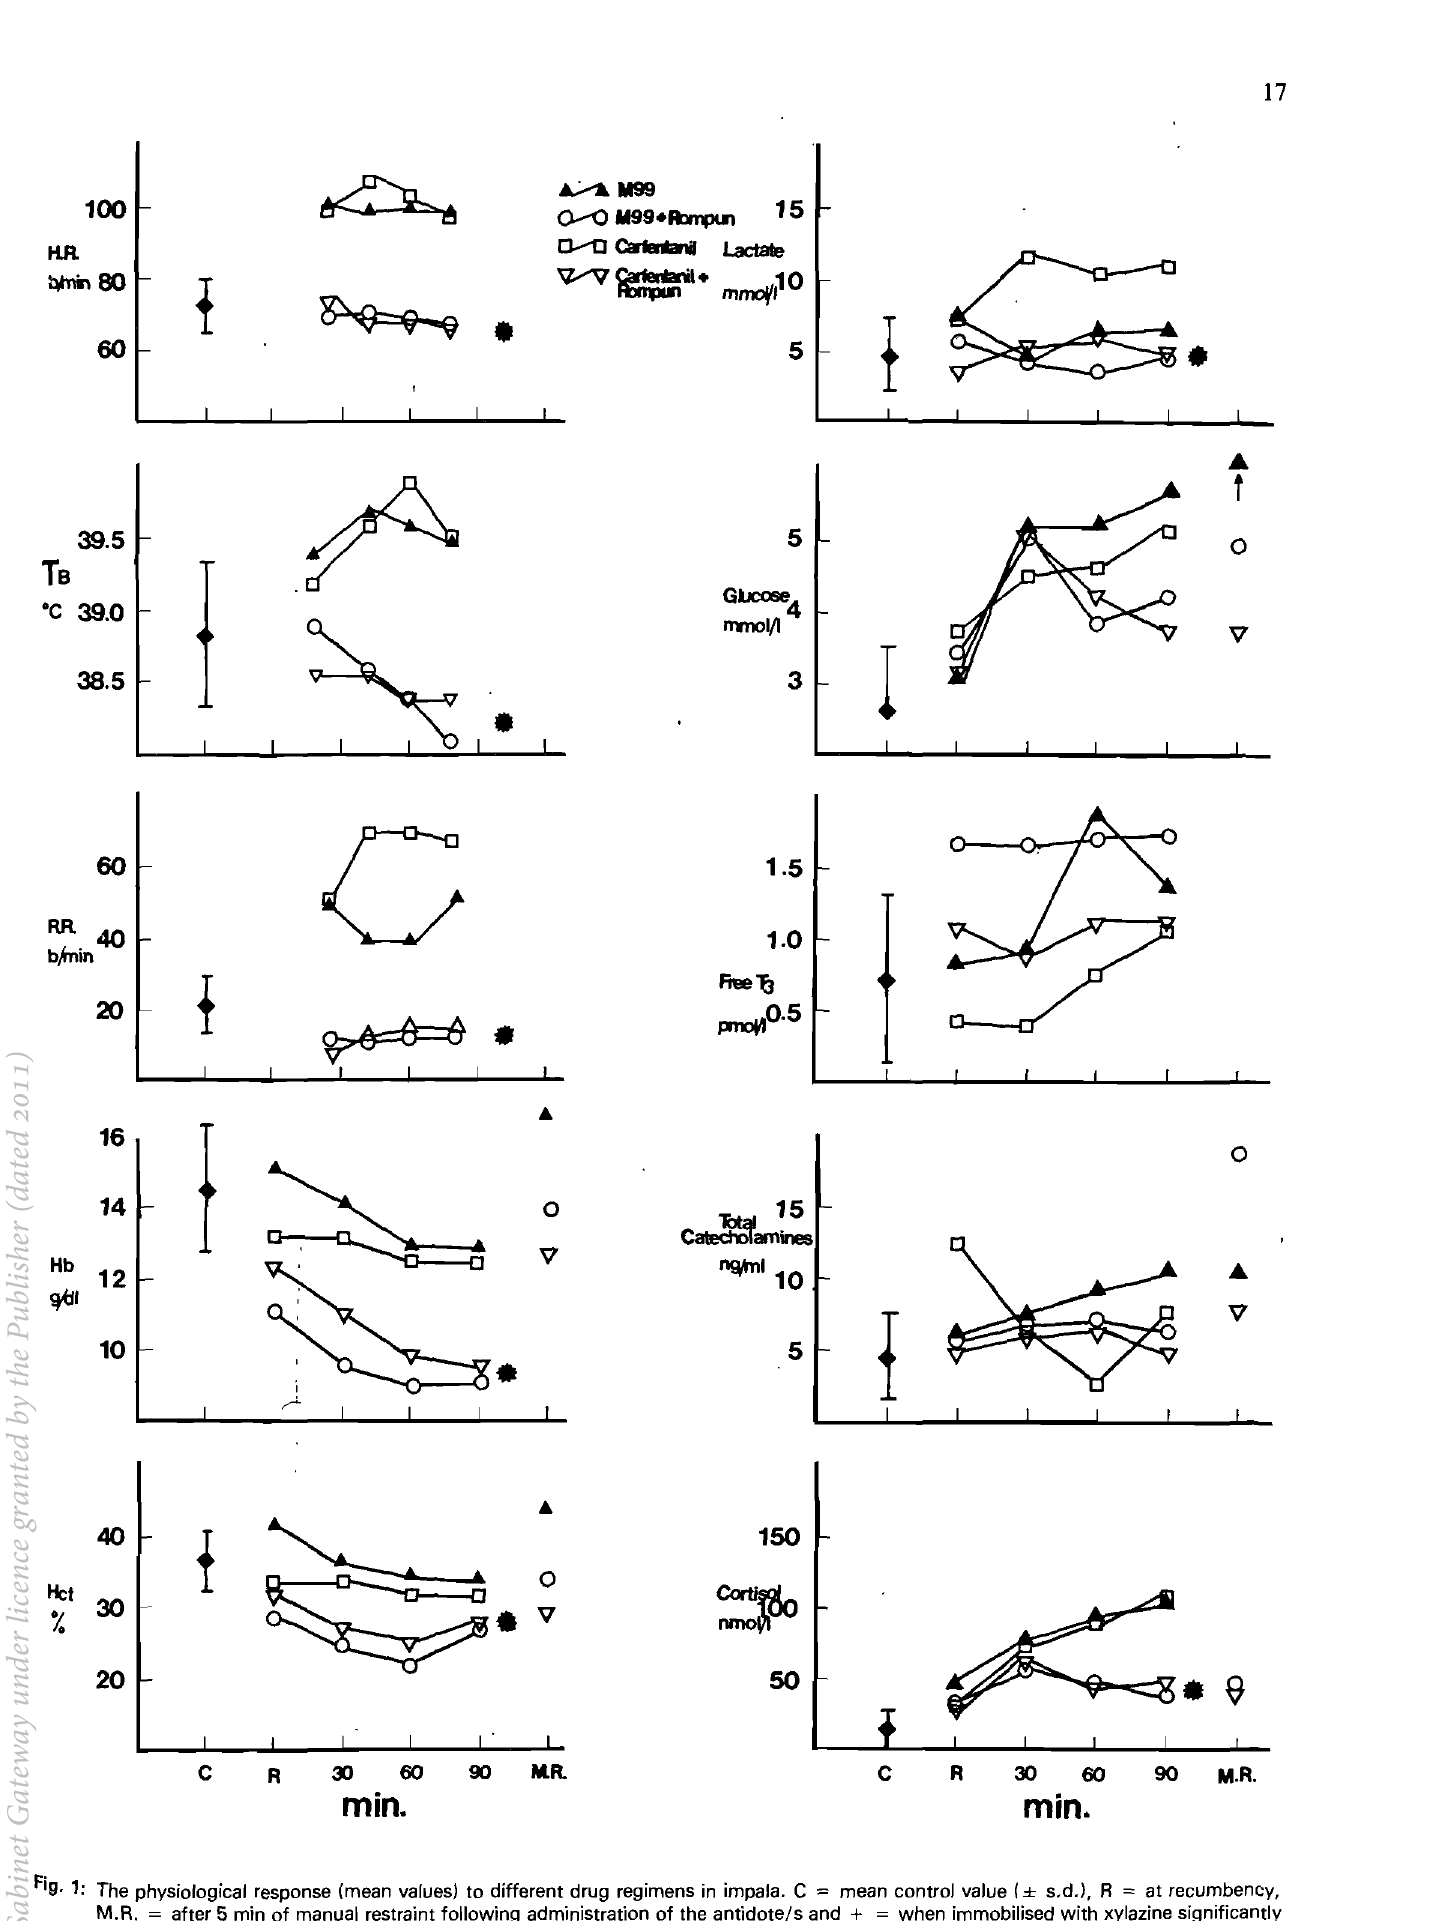
Fig. 1: The physiological response (mean values) to different drug regimens in impala. C = mean control value (± s.d.), R = at recumbency, M.R. = after 5 min of manual restraint following administration of the antidote/s and + = when immobilised with xylazine significantly different from values obtained with only etorphine HCI or carfentanil. Standard deviations omitted for the sake of clarity. See text for full